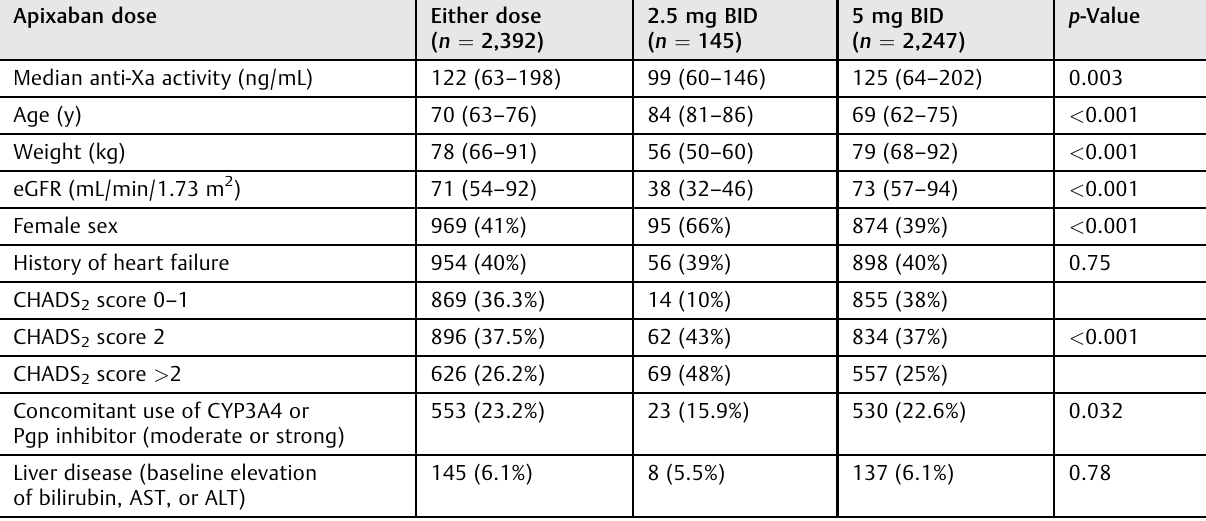
Table 1 Apixaban anti-Xa activity (ng/mL) and clinical characteristics for the entire group and according to apixaban dose Apixaban dose